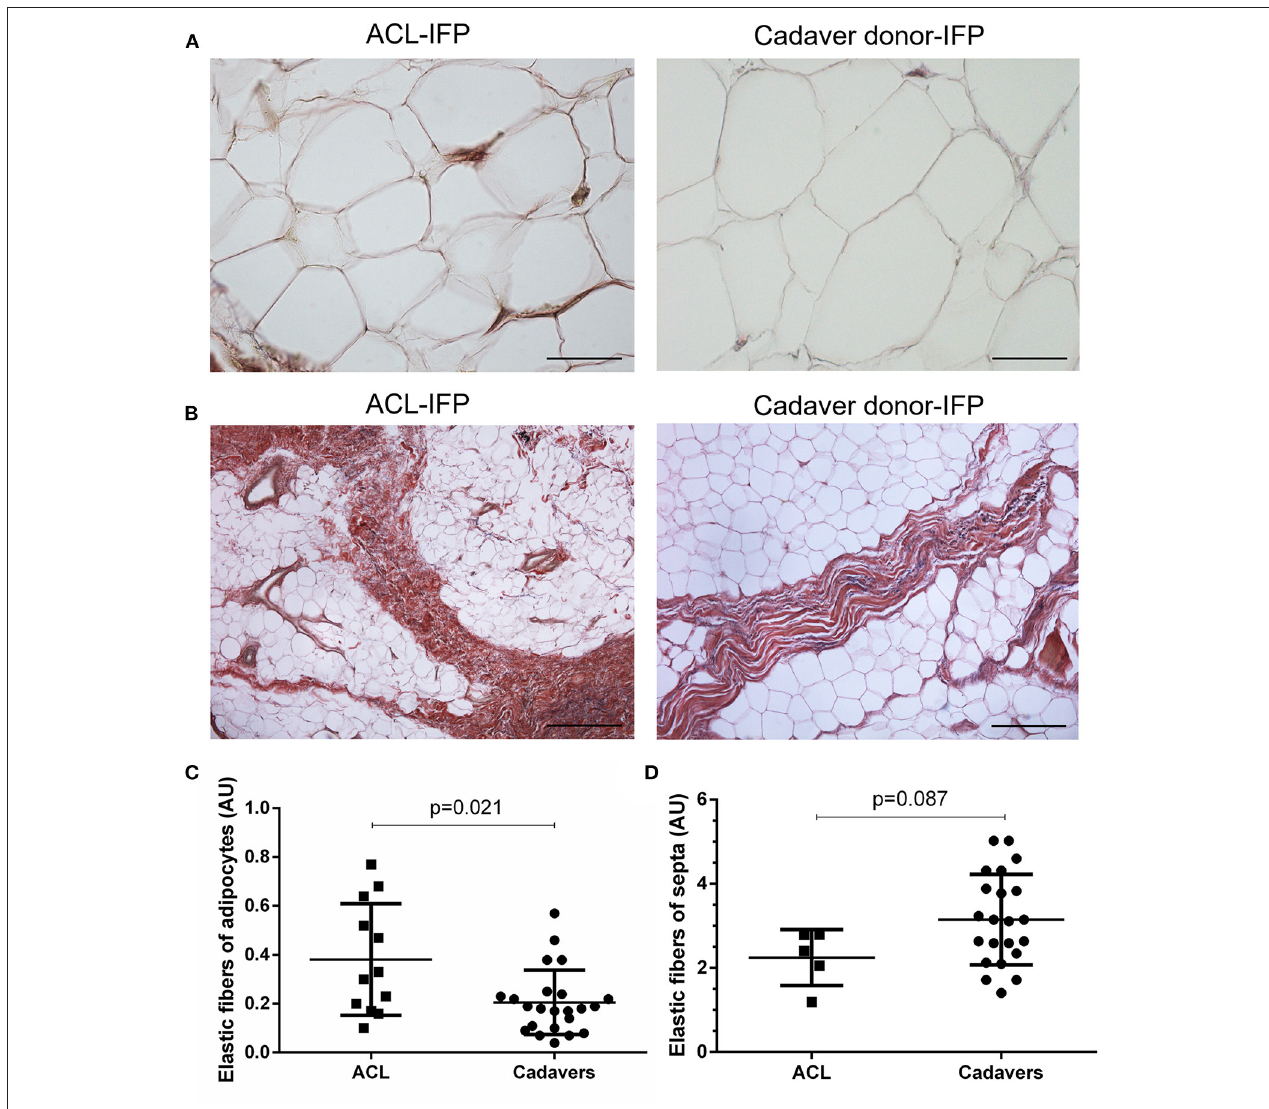
FIGURE 5 | Elastic fibers distribution. Van Gieson staining showed in violet the elastic fibers orientation around the adipocytes (A) (scale bar = 200 µ m) and in correspondence of the septa (B) (scale bar = 50 µ m) for ACL-IFPs and cadaver donors-IFPs. Quantification of the elastic fibers showed differences in the two settings. Significantly, higher elastic fibers were observed around the adipocytes in the ACL-IFPs ( p = 0.021) (C) but not in correspondence of the septa in the cadaver donors-IFPs ( p = 0.0872) (D) . For the adipocytes surrounding areas, data analysis considered n = 12 and n = 23 tissue samples for ACL-IFPs and cadaver donors-IFPs, respectively; for the septa, data analysis considered n = 5 and n = 23 tissue samples for ACL-IFPs and cadaver donors-IFPs, respectively. AU, arbitrary